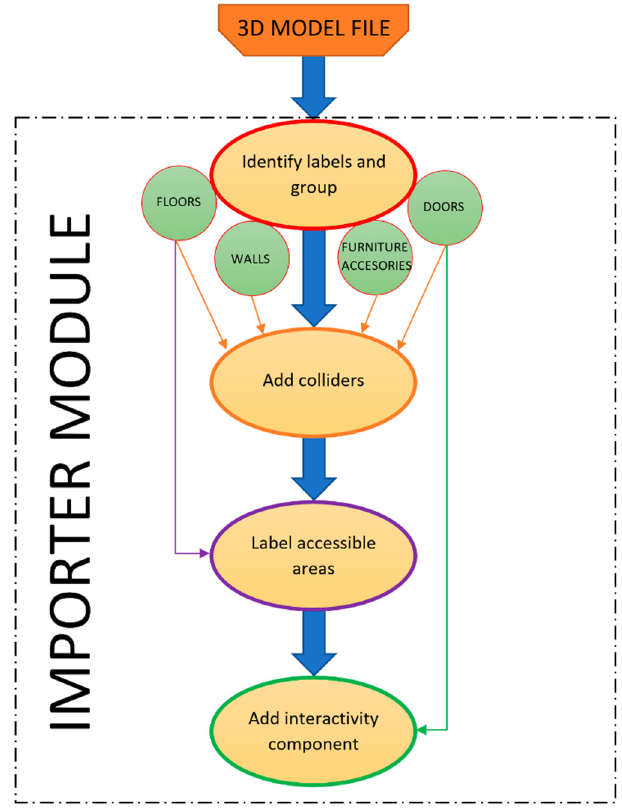
Figure 4. Functions of the importer module which add properties to the 3D elements inside Unity.